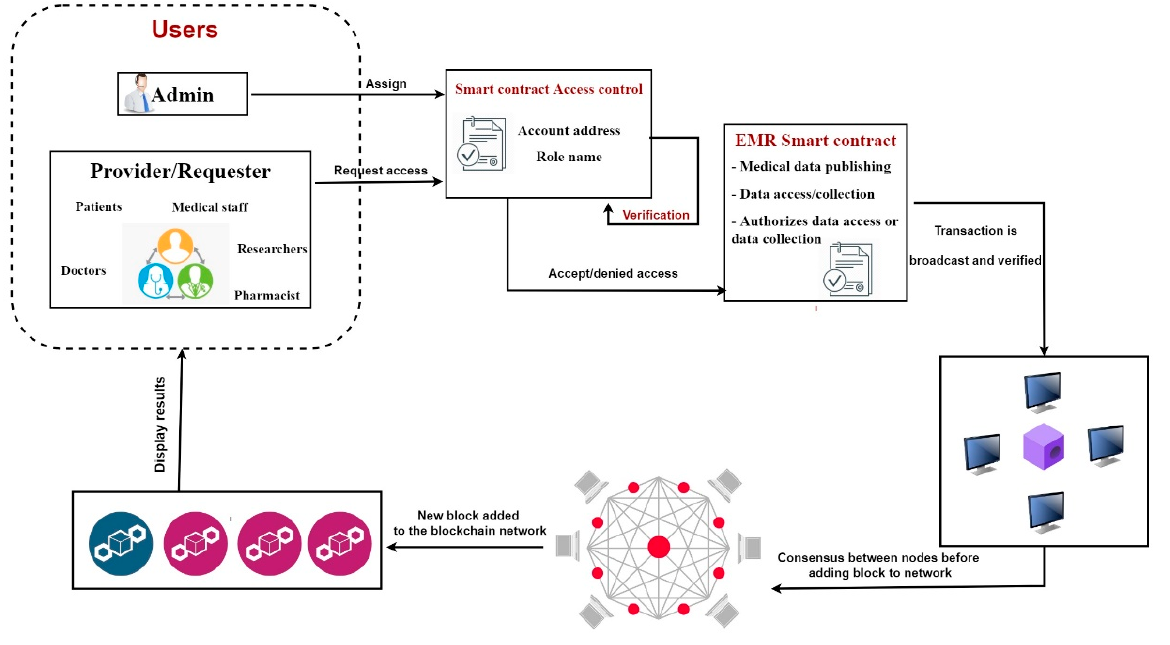
Figure 3. Smart healthcare services based on blockchain technology.